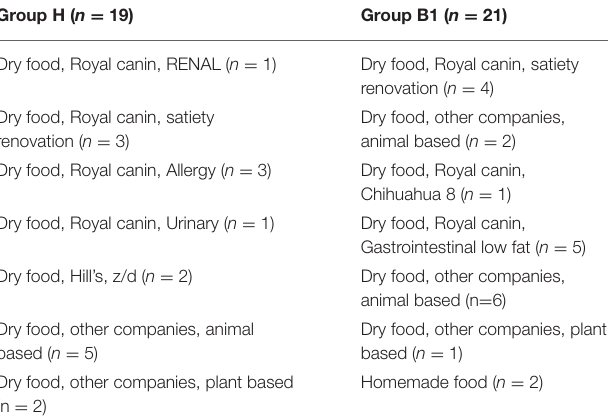
TABLE 2 | Patient diet data in healthy Chihuahuas (H) and Chihuahuas with myxomatous mitral valve disease divided into three groups (B1, B2, and C/D).